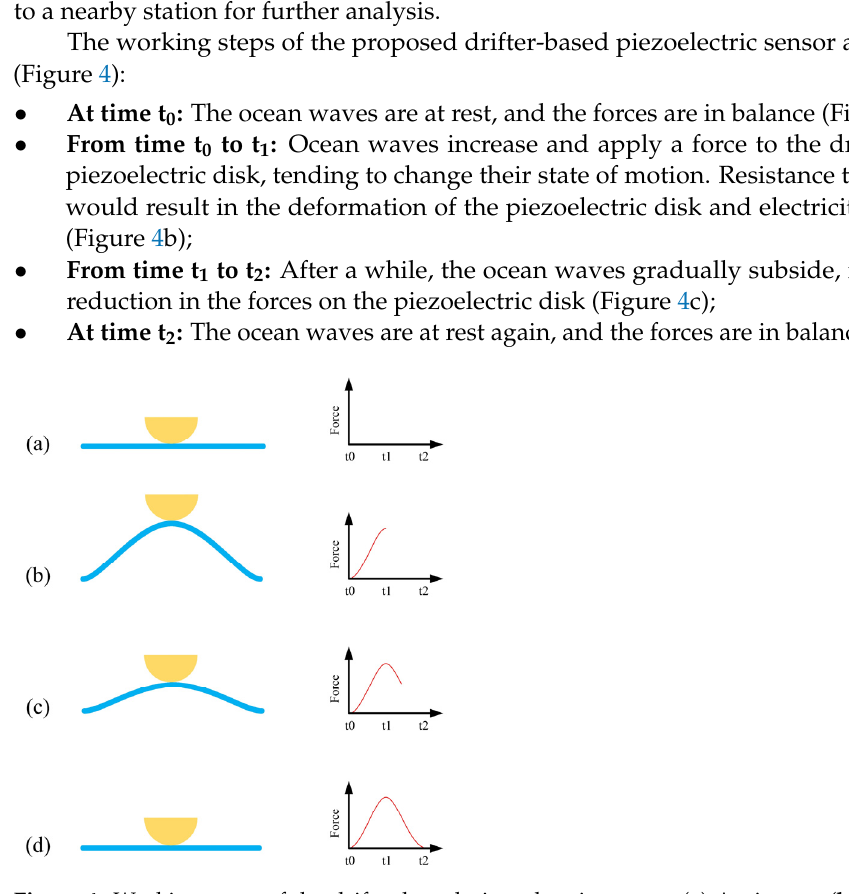
Figure 4. Working steps of the drifter-based piezoelectric sensor: ( a ) At time t 0 ; ( b ) From t 0 to t 1 ; ( c ) From time t 1 to t 2 ; ( d ) At time t 2 .